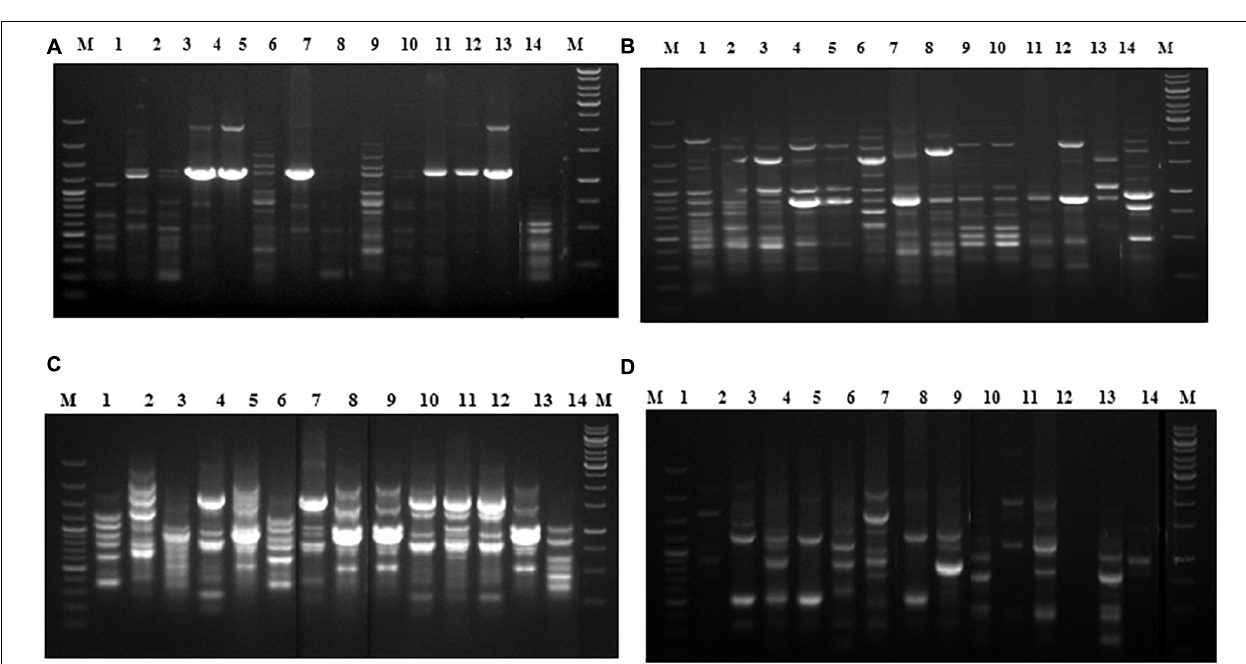
FIGURE 2 | Phylogenetic tree based on ITS gene sequences, drawn using the Maximum likelihood method and showing the relation between Fusarium strains.